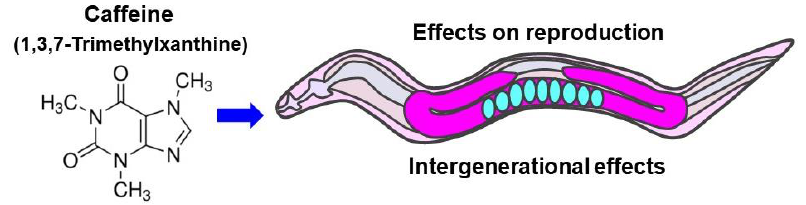
Figure 1. Caenorhabditis elegans P0 mothers were fed single compound caffeine (1,3,7-